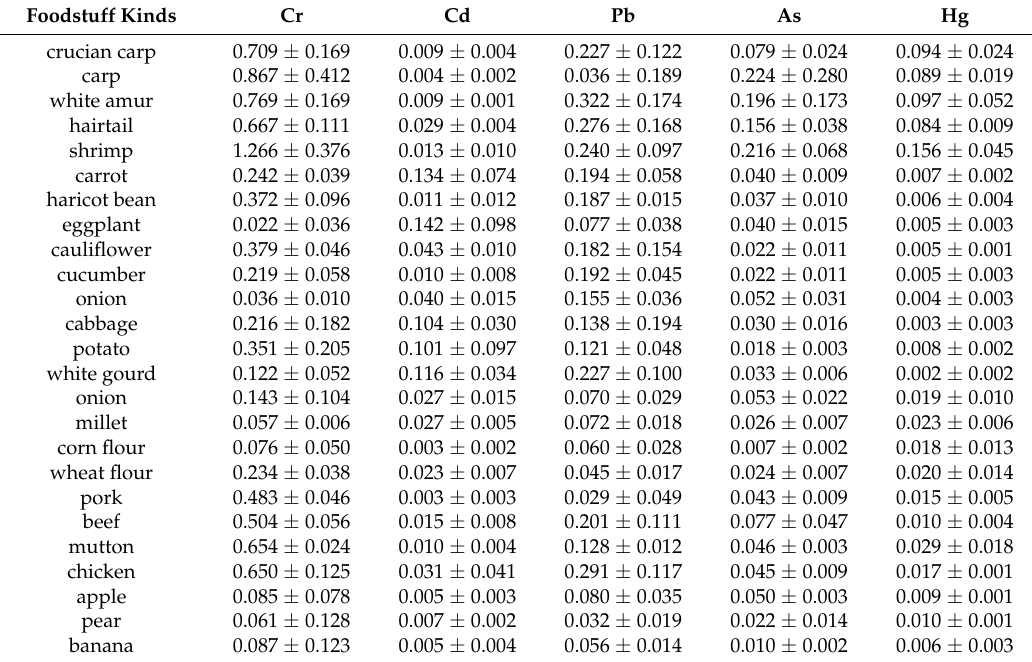
Table 1. Heavy metal concentrations in different foodstuff types